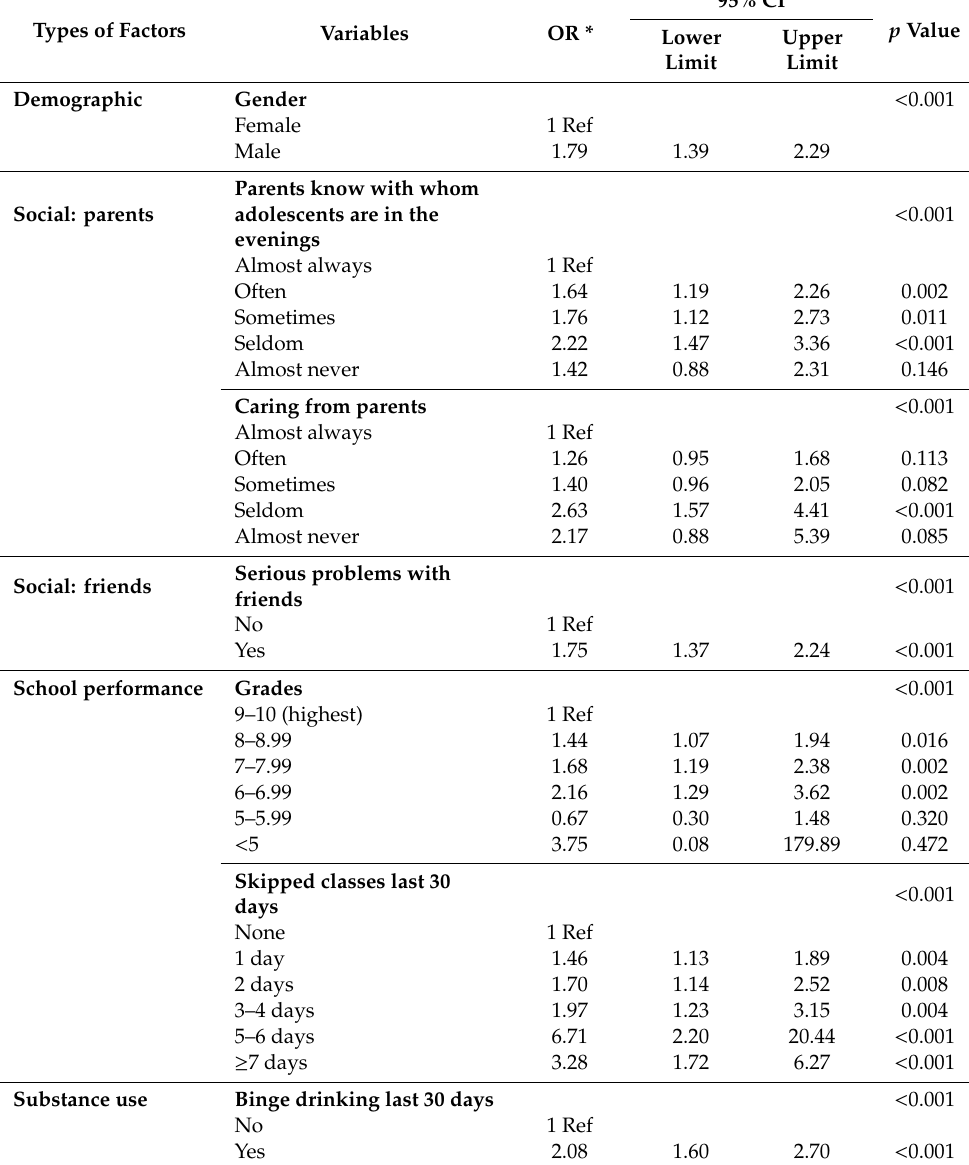
Table 2. Factors associated with physical fight experienced by Romanian students during the last 12 months determined by multivariate analysis for the 2011